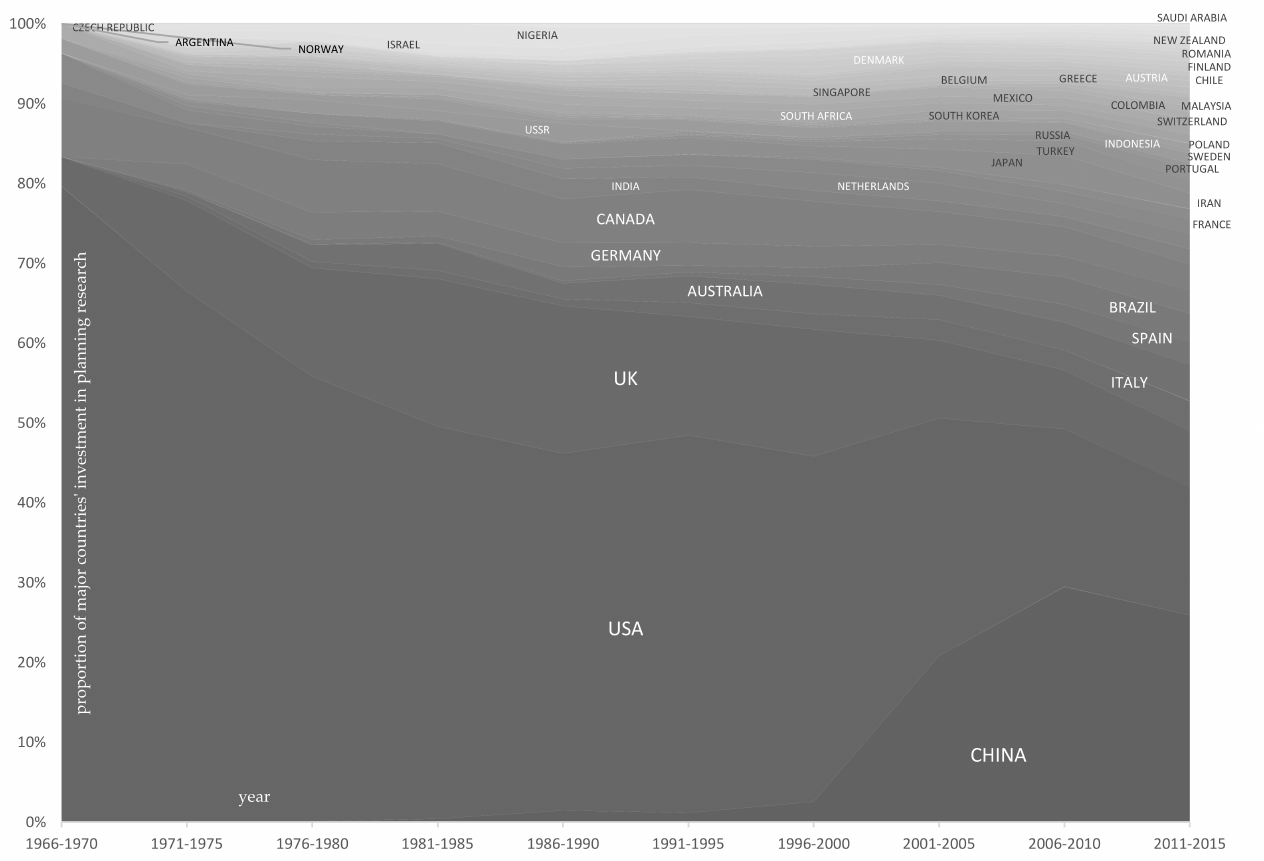
Figure 2. The proportion of major countries’ investment in planning research [30]. Source: based on data from Web of